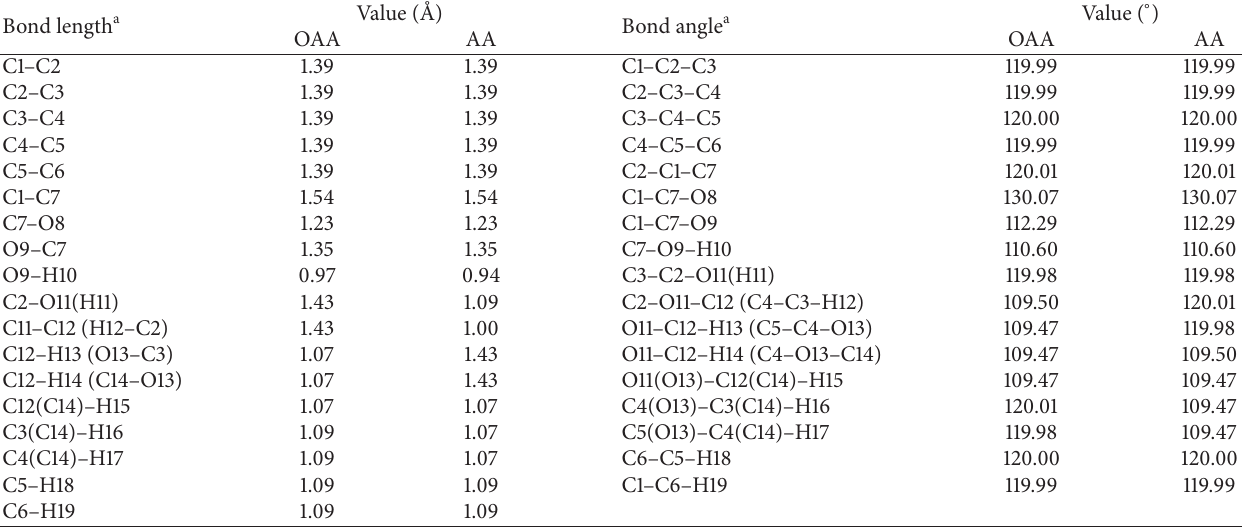
Table 1: Optimized geometrical parameters O-Anisic acid (OAA) and Anisic acid (AA) obtained by B3LYP/6-31G ∗∗ density functional cal-